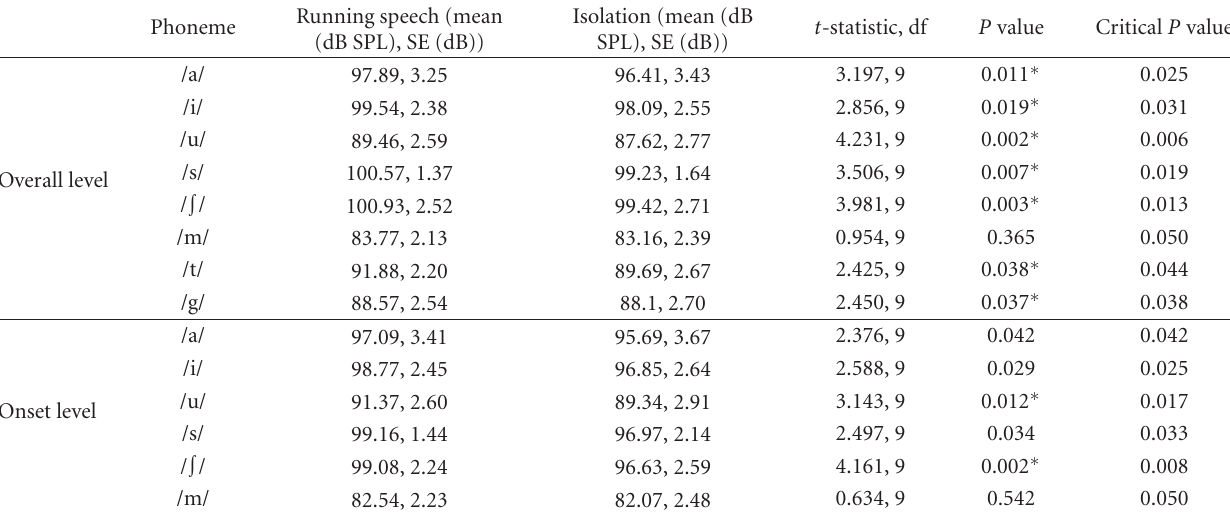
Table 4: Results of post hoc tests for phoneme context